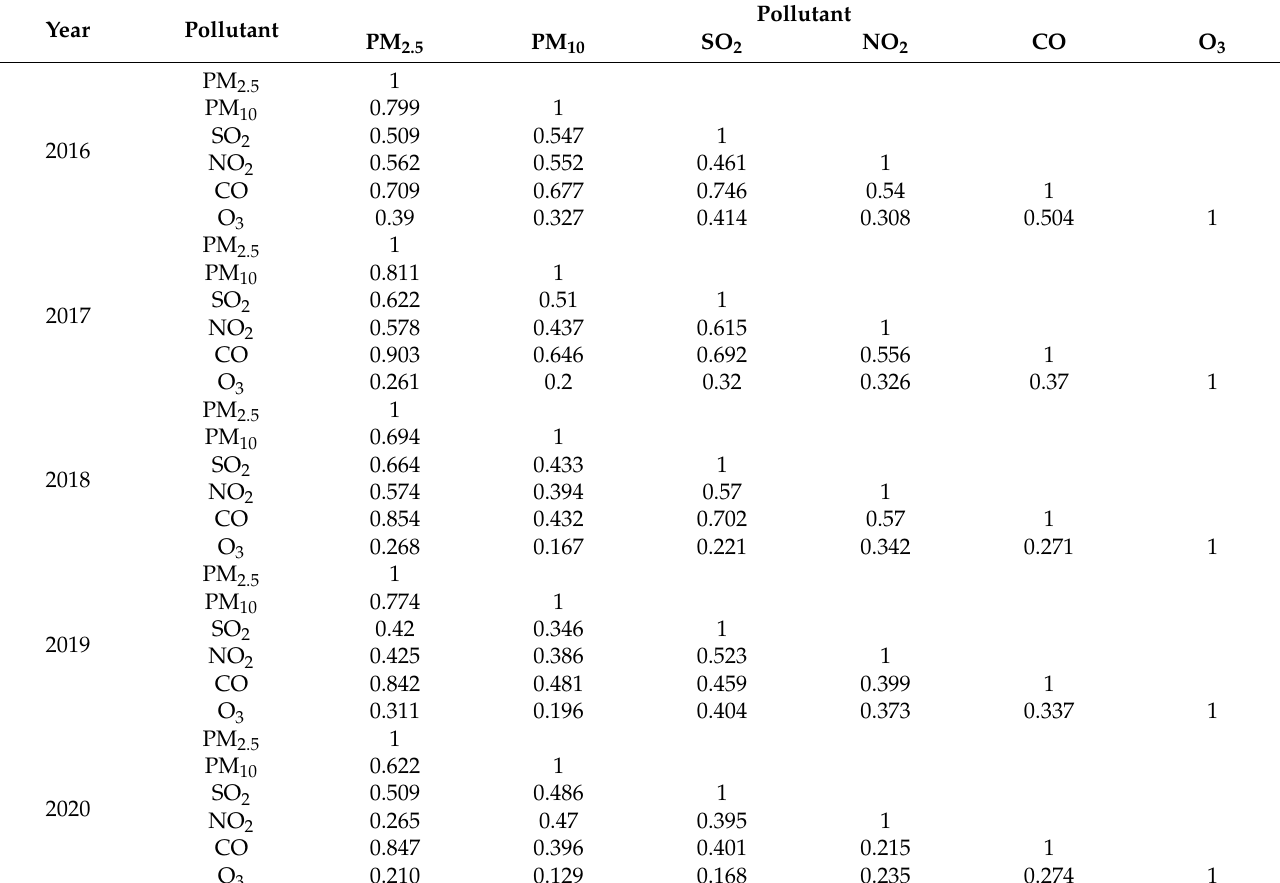
Table 3. Correlations among air pollutants in the atmosphere from 2016 to